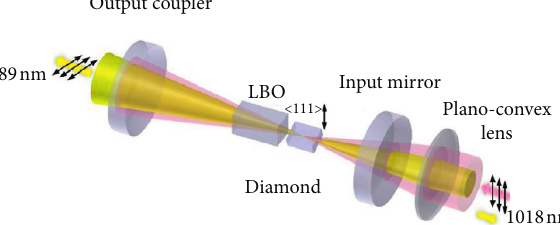
Figure 19: Schematic of the 589nm diamond Raman laser with intracavity second-harmonic generation [73].